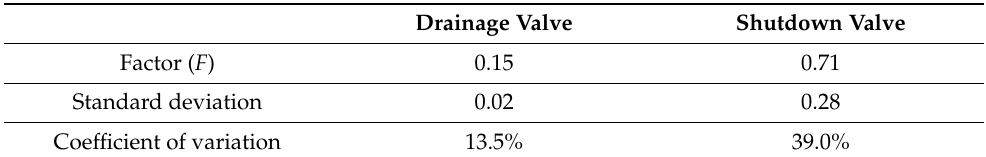
Table 3. Calculated average matching factors for the two valve types, with their standard deviations and coefficients of variation.